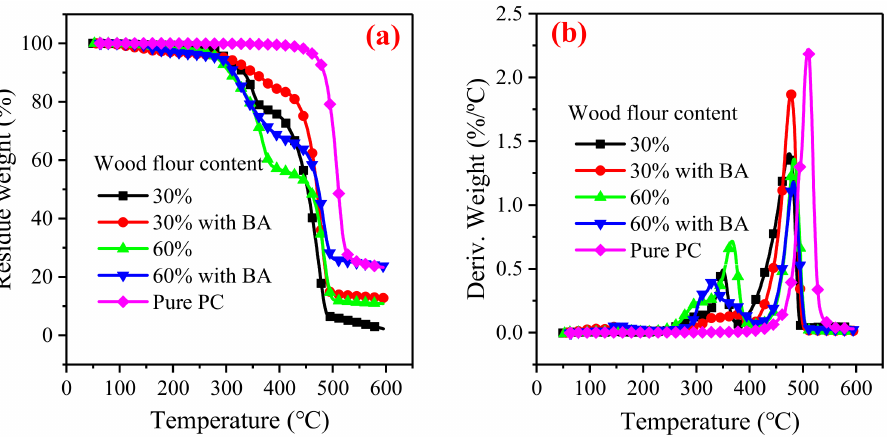
Figure 2. TG ( a ) and DTG ( b ) curves of the wood flour/HDPE composites and pure